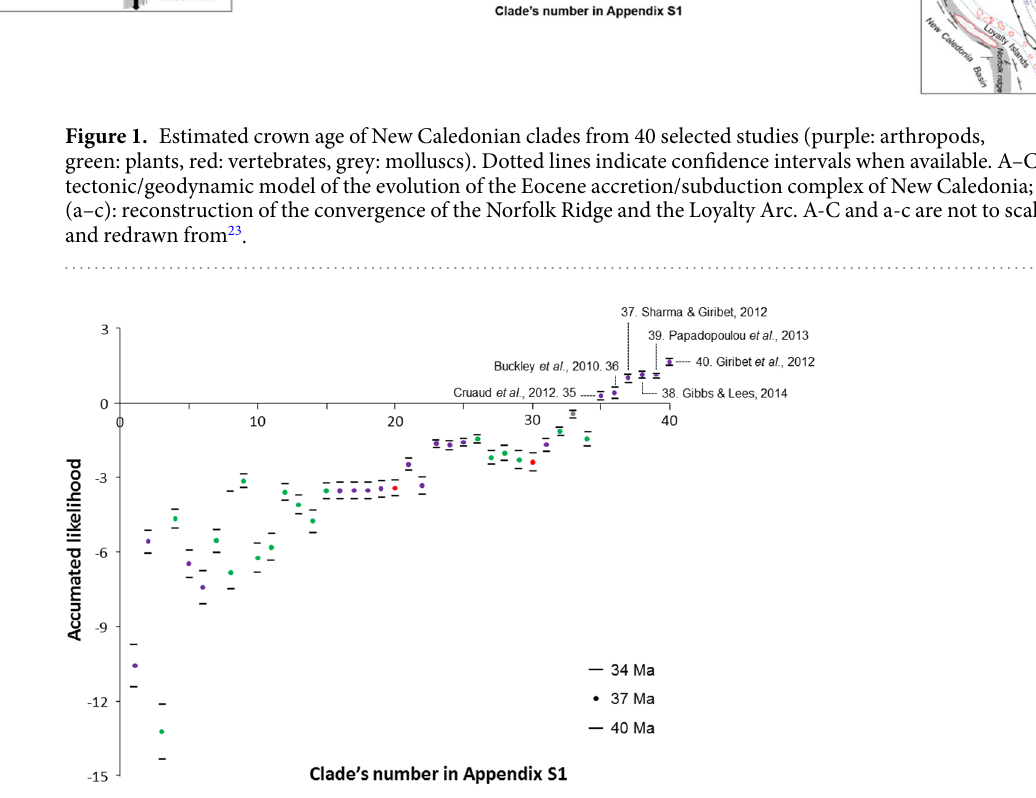
Figure 2. Accumulated likelihood of being older than 37 Ma ( ± 3 Ma). Numbers on the X-axis refer to the Clade ID in Table 1. Purple: arthropods, green: plants, red: vertebrates, grey: